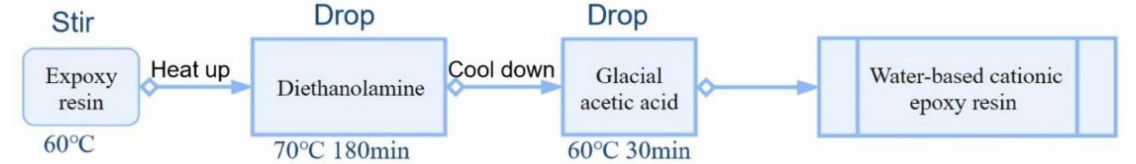
Figure 1. Synthesis method of cationic epoxy resin.